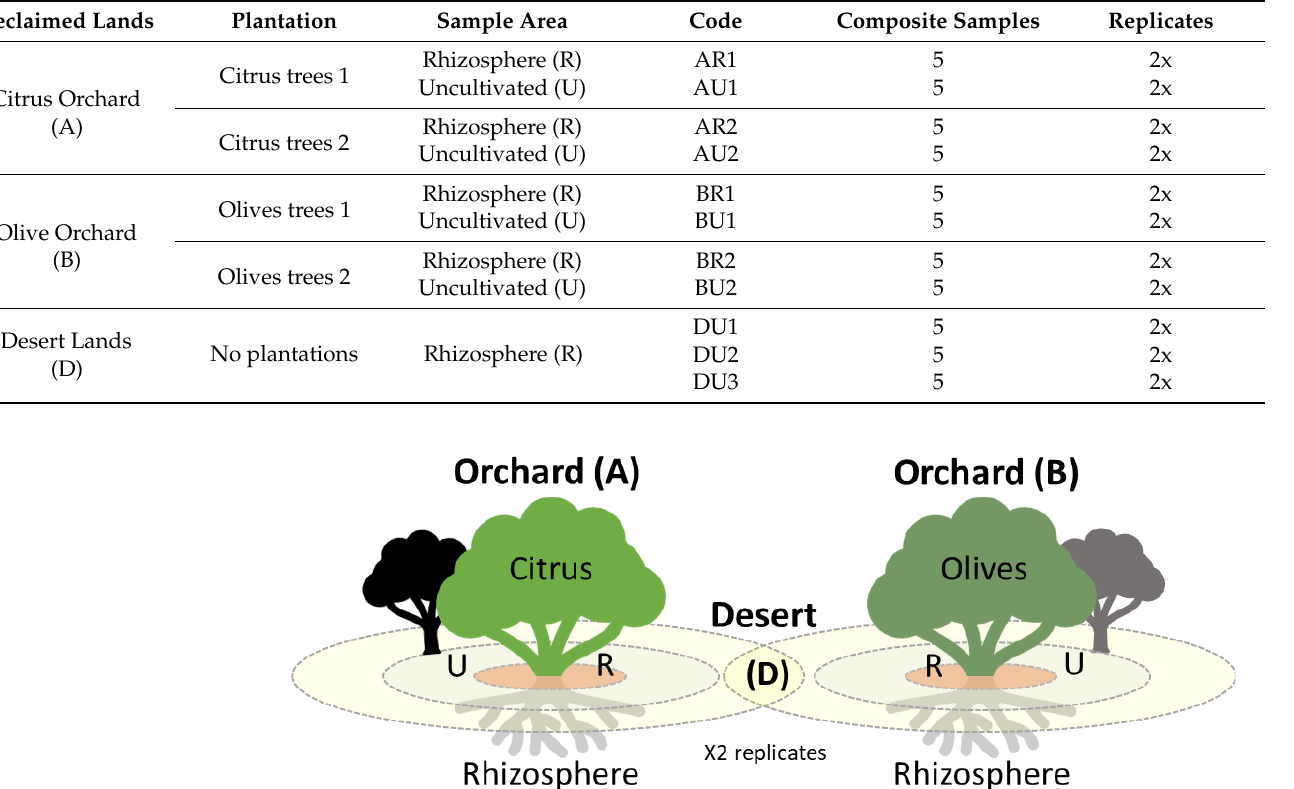
Table 1. A list of sample codes describing the land type, plantation, and collection area for each sample type.